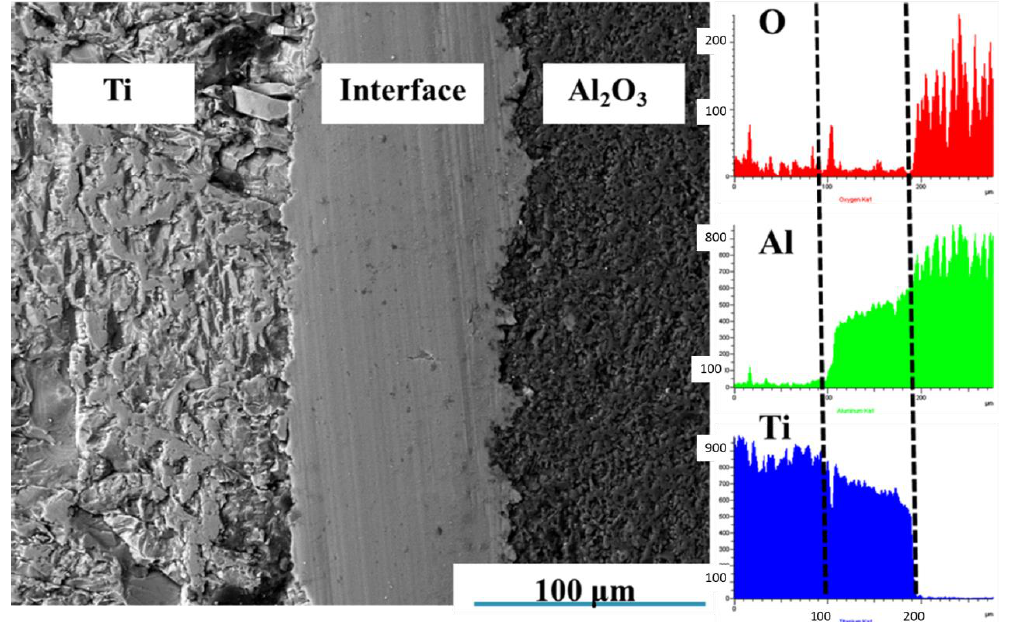
Figure 5. SEM images and line scanning analysis of interface at 1450 °C holding for 1.5 h.